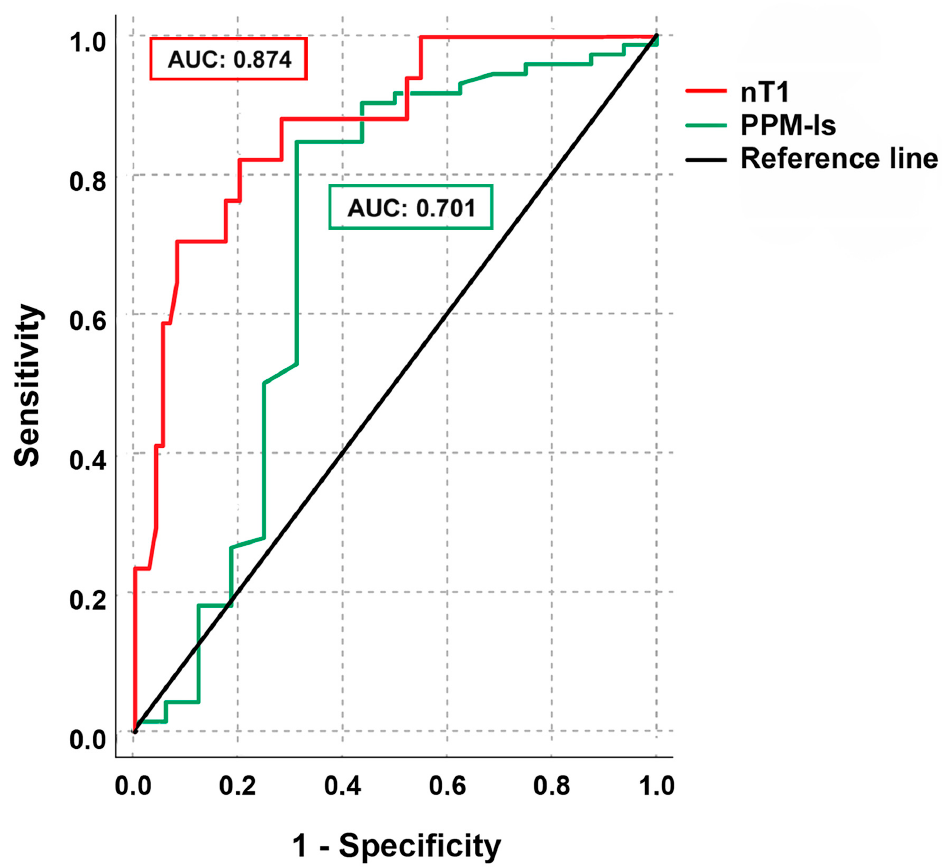
Figure 6. ROC analysis illustrates the diagnostic performance of nT1 and PPM-ls to detect iPPM. AUC: area under the curve, nT1: native T1; PPM-ls: PPM-longitudinal